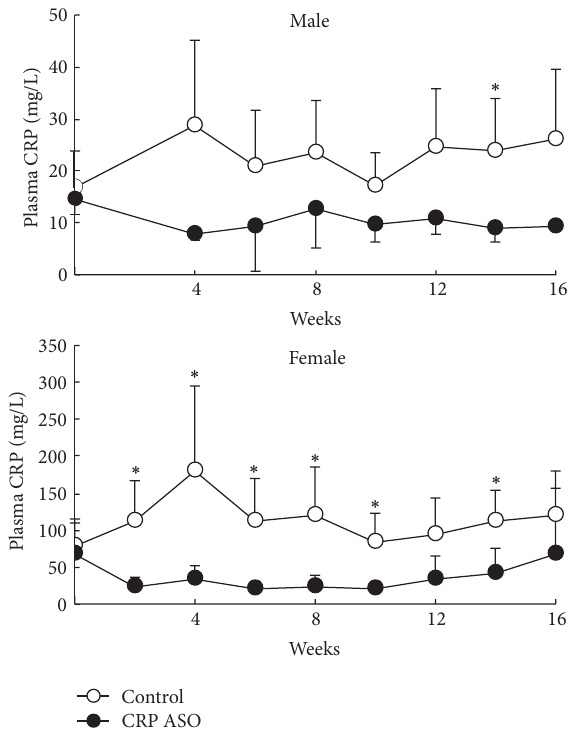
Figure 6: Plasma levels of CRP in WHHL rabbits. Plasma CRP levels were measured every two weeks after CRP ASO treatment. The values are expressed as the mean ± SD. 𝑛 = 5 for each group. ∗ 𝑃 < 0.05 versus control.